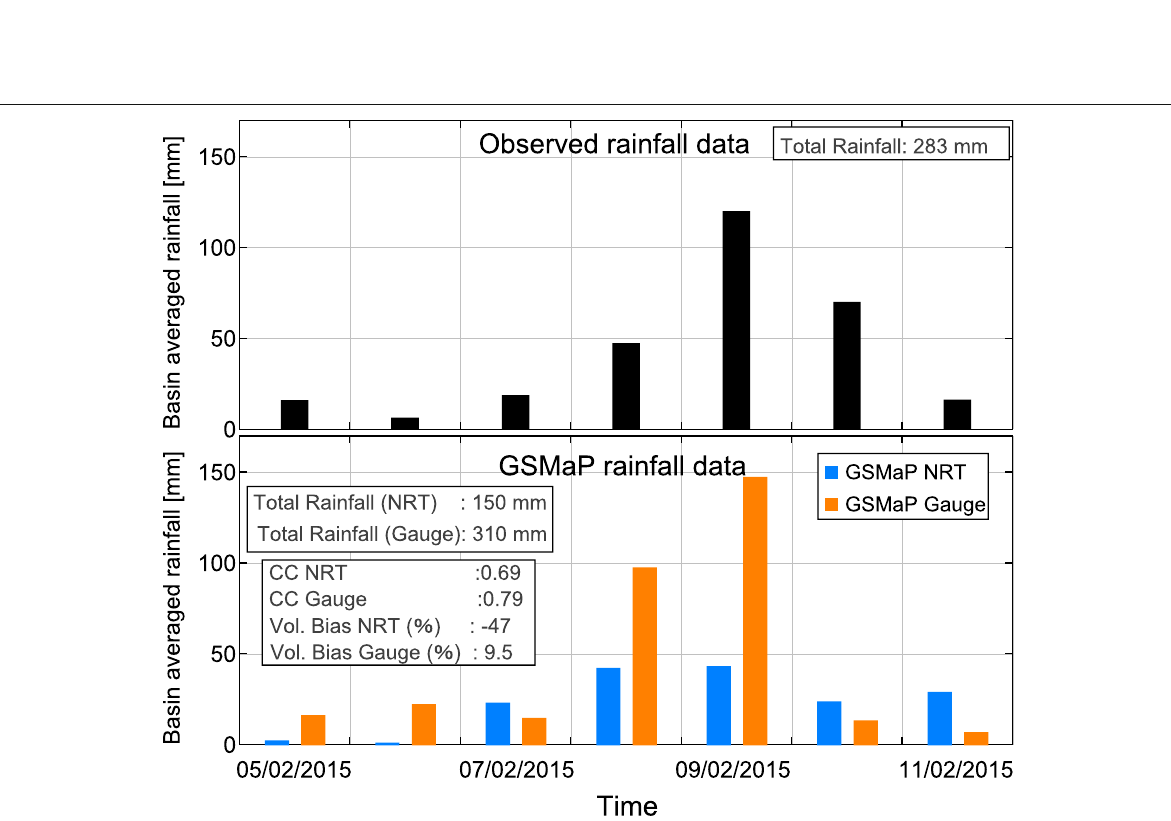
Fig. 3 Comparisons of daily rainfall between GSMaP products (NRT & Gauge V7) and observation for flood event in